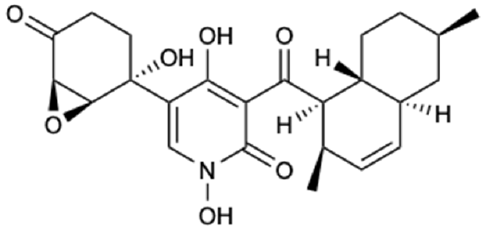
Figure 19. Structure of didymellamide A ( 71 ).